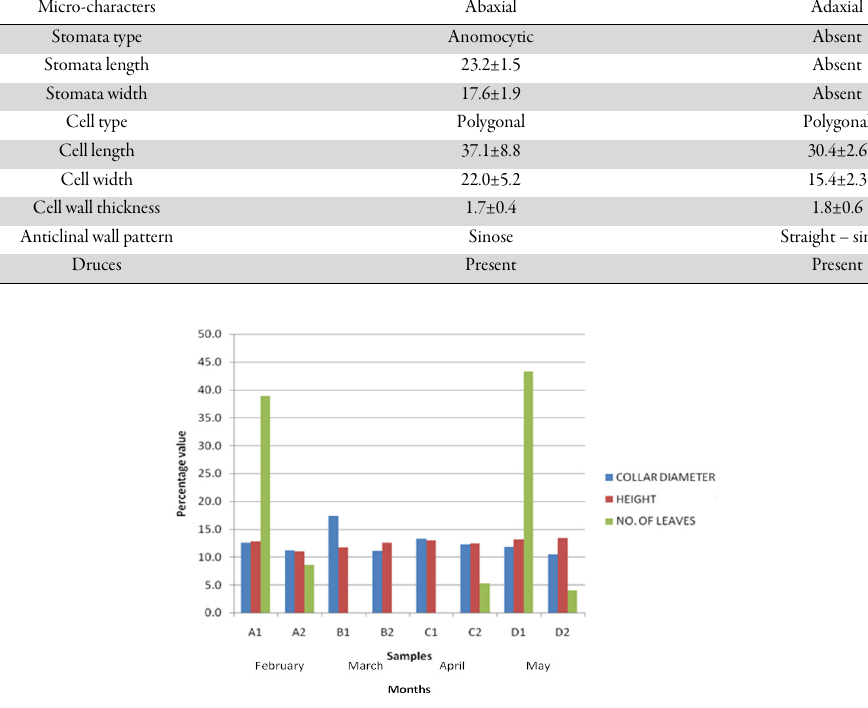
Table 3. Foliar micro-characters of D. tripetala